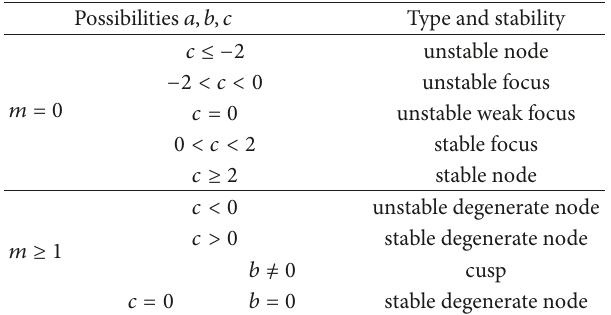
Table 1: Qualitative properties of equilibria 𝑂 . Possibilities 𝑎,